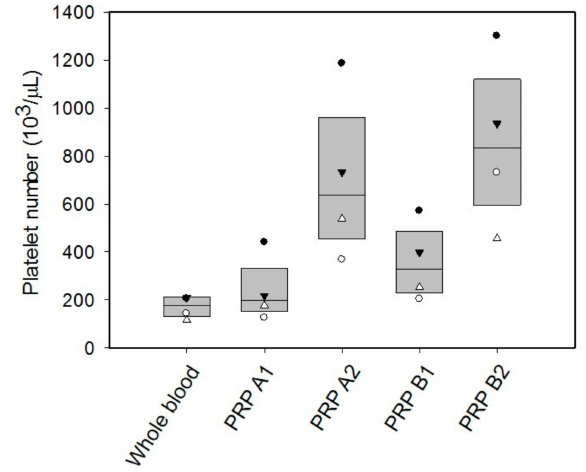
Figure 5. Platelet number in the PRP prepared by 4 different procedures. The blood samples were collected from 4 donors in the ages of 49, 50, 70, and 72. Different symbols represent the data points from different donors. The data are presented as mean ± standard deviation